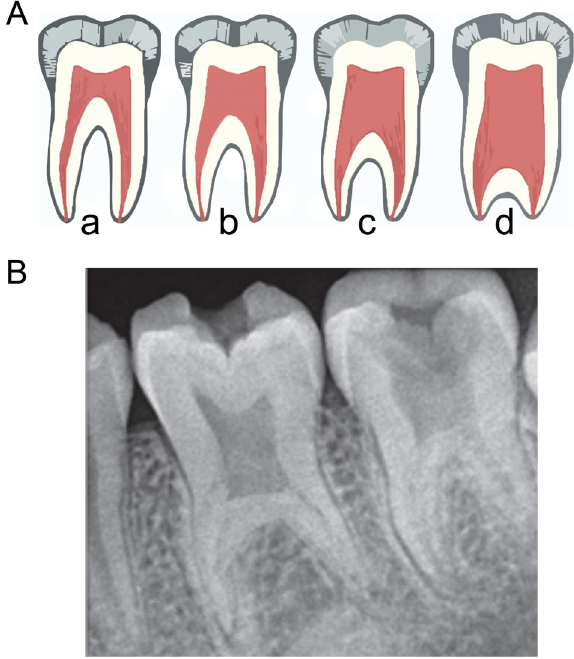
Fig. 1 Taurdontism in molar teeth. A Diagrammatic representa- tions of taurodontic teeth: ( a ) Normal molar, ( b ) hypotaurodintism, ( c ) mesotaurodontism, ( d ) hypertaurodontism; b radiographic image of a molar with features of taurodontism. B Reproduced with permission from Silva et al. 32 available from https://doi.org/10.1590/ 1981-863720150002000101733.